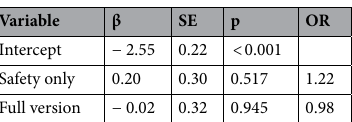
Table 3. Logistic regression of intervention condition on increased intention to get vaccinated.